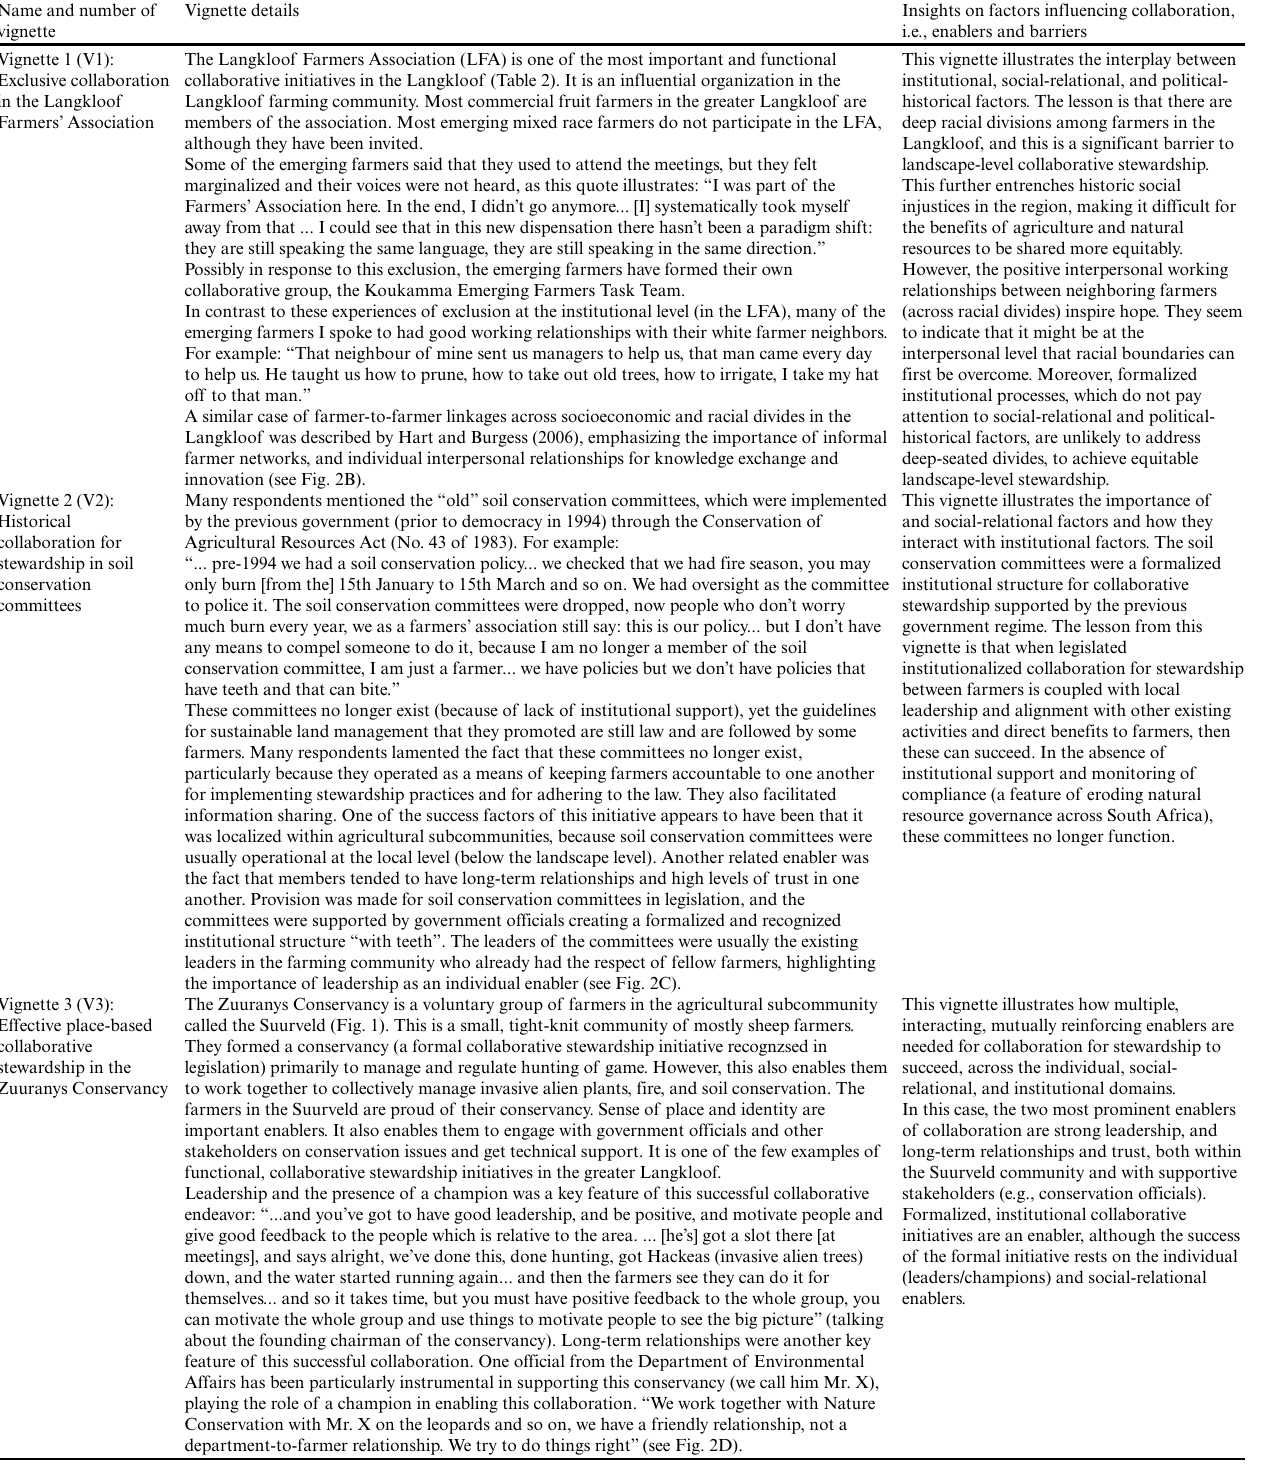
Table 3 . Vignettes illustrating the factors influencing collaboration in the Langkloof region (see photos in Fig.